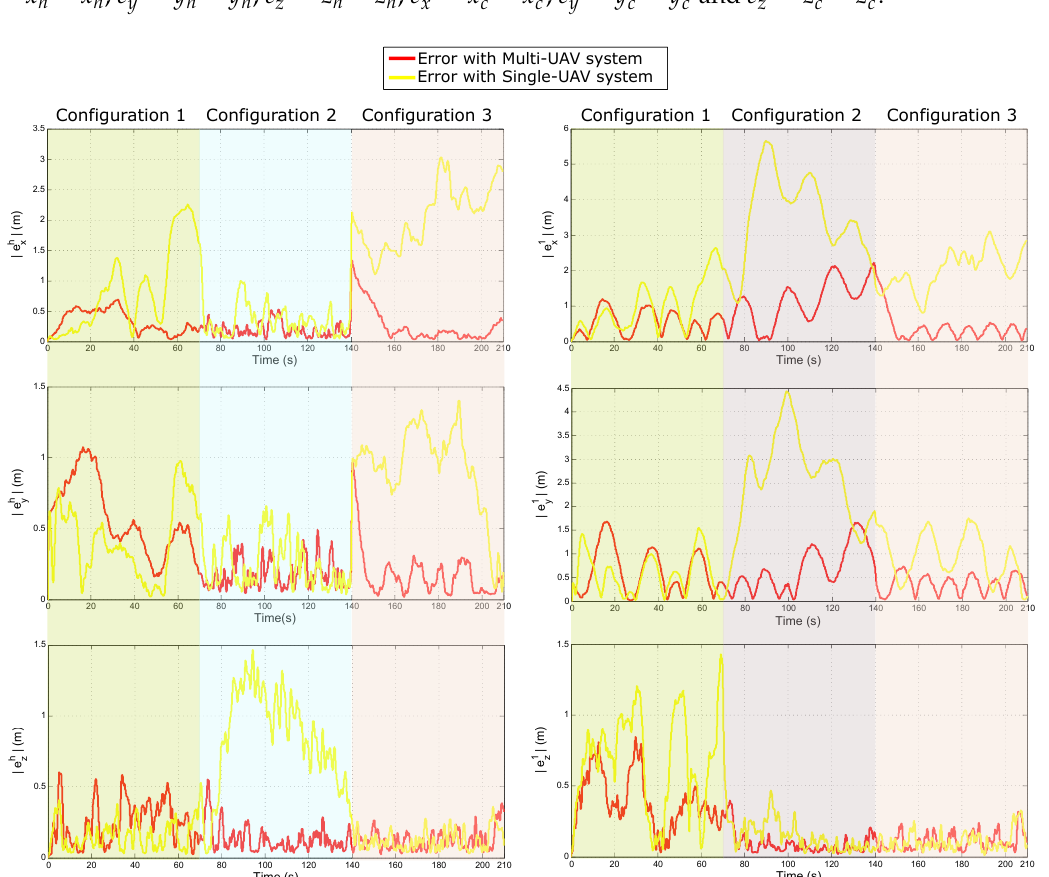
Figure 10. Comparison of the quality of the estimated trajectory obtained with the Multi-UAV system respect to the trajectory obtained with the Single-UAV system. Left column of plots illustrates the errors obtained for the lead agent. Right column of plots illustrates the errors obtained for the Quad